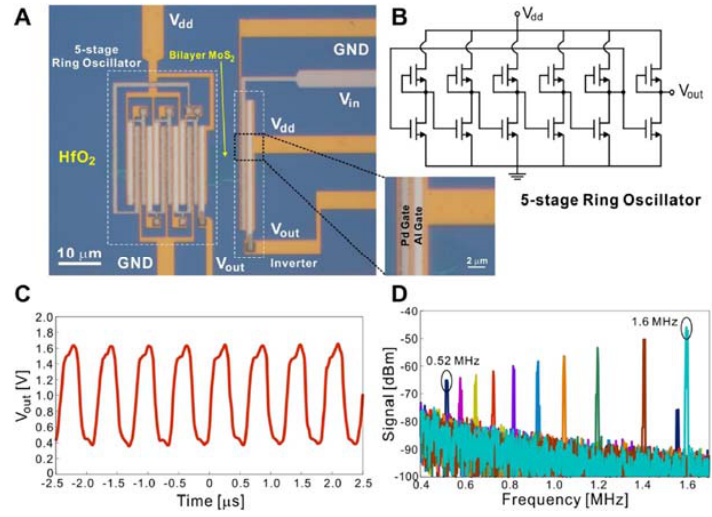
Figure 21. A five ‐ stage ring oscillator based on bilayer MoS 2 . ( A ) Optical micrograph of the ring oscillator constructed on a bilayer MoS 2 thin film. ( B ) Schematic of the electronic circuit of the five ‐ stage ring oscillator. The first five inverter stages form the positive feedback loop, which leads to the oscillation in the circuit. The last inverter serves as the synthesis stage. ( C ) Output voltage as a function of time for the ring oscillator at V dd = 2 V. (D) The power spectrum of the output signal as a function of V dd . From left to right, V dd = 1.15 V and 1.2 to 2.0 V in steps of 0.1 V. The corresponding fundamental oscillation frequency increases from 0.52 to 1.6 MHz. Reproduced with permission from [249], American Chemical Society, 2012.